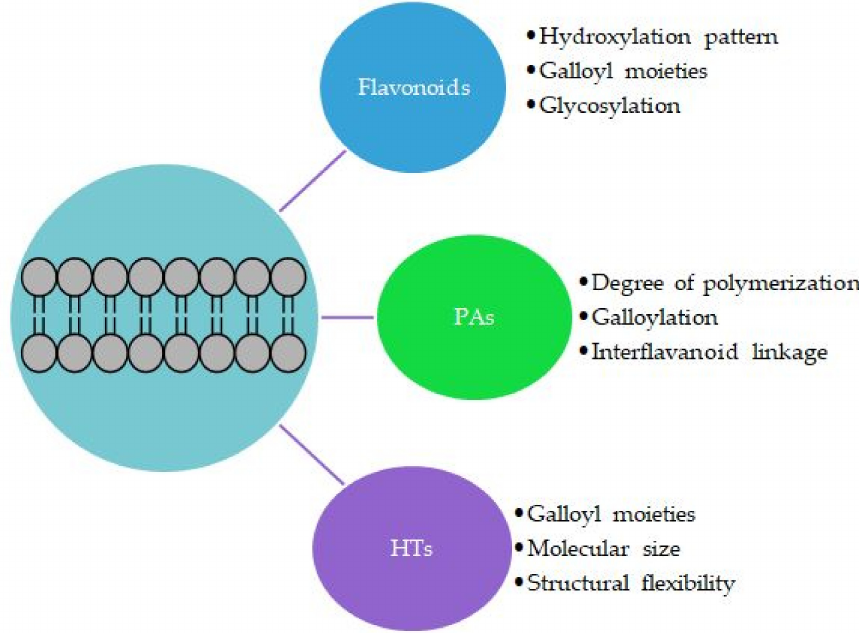
Figure 5. Main structural features of polyphenols affecting their interactions with the lipid bilayers; PAs = proanthocyanidins, HTs = hydrolysable tannins. In addition, the physicochemical proper- ties, such as hydrophobicity and dipole moment, of the polyphenol, the lipid composition and intermolecular forces